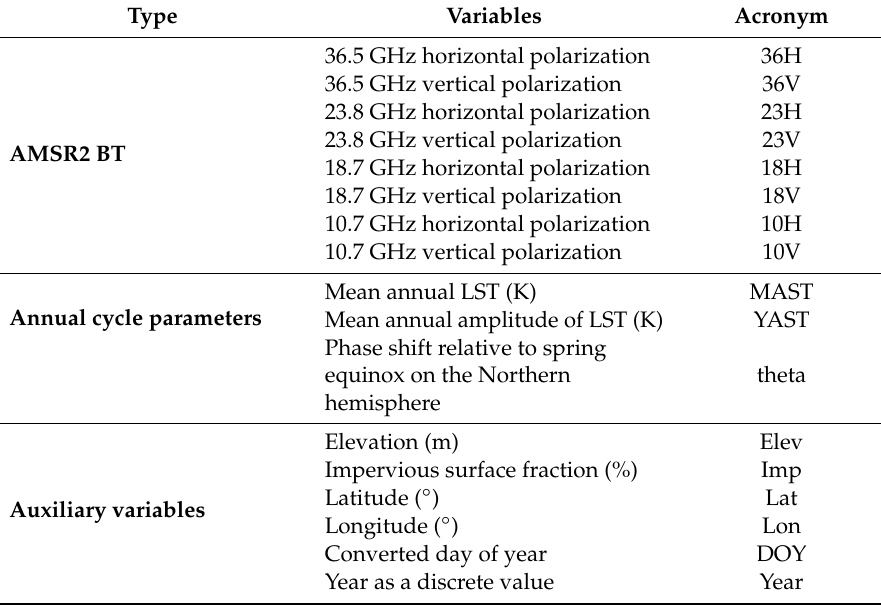
Table 1. Description of input variables used in this